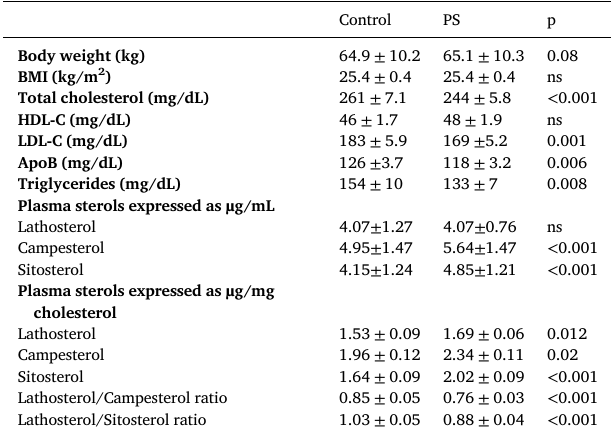
Table 3 Body weight, BMI, biochemical analysis, plasma sterol concentrations of patients in the Control and on the PS phases, n =